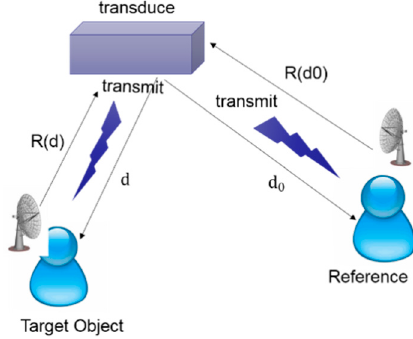
Figure 3. Received Signal Strength Intensity (RSSI) model.